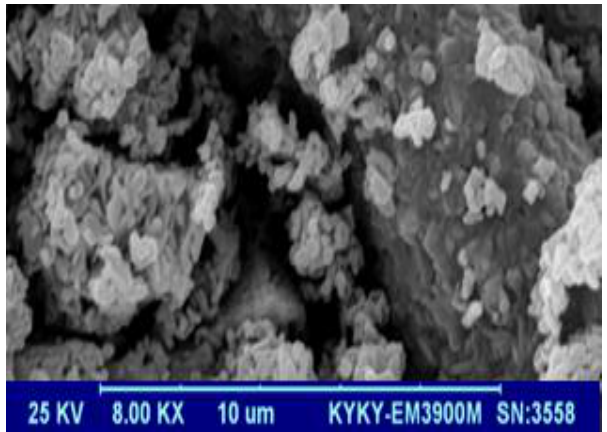
Figure 5. SEM image of BFO/CFO@PEG nanocomposites.